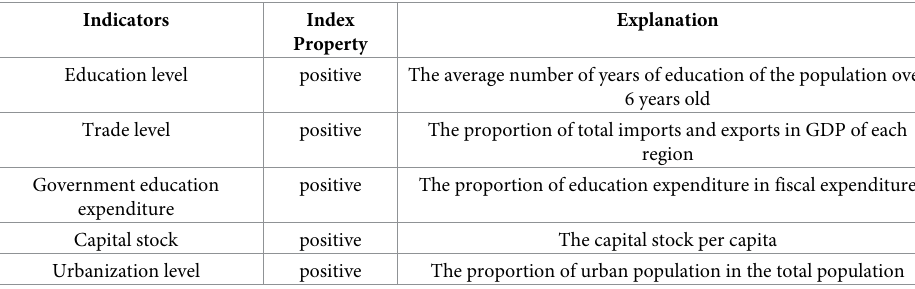
Table 3. The index system of control